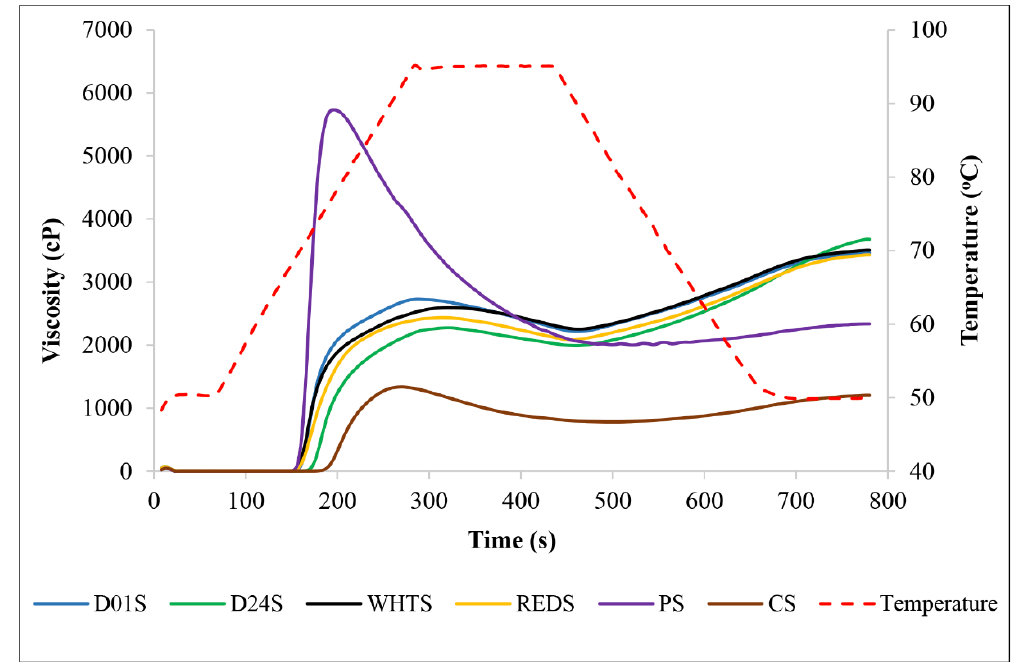
Figure 3. Viscometric profiles of starches from four cultivars of anchote (D01S = Desta 01 starch, D24S = Desta 24 starch, WHTS = white starch, REDS = red starch). Potato (PS) and cassava (CS) starches are included as references.